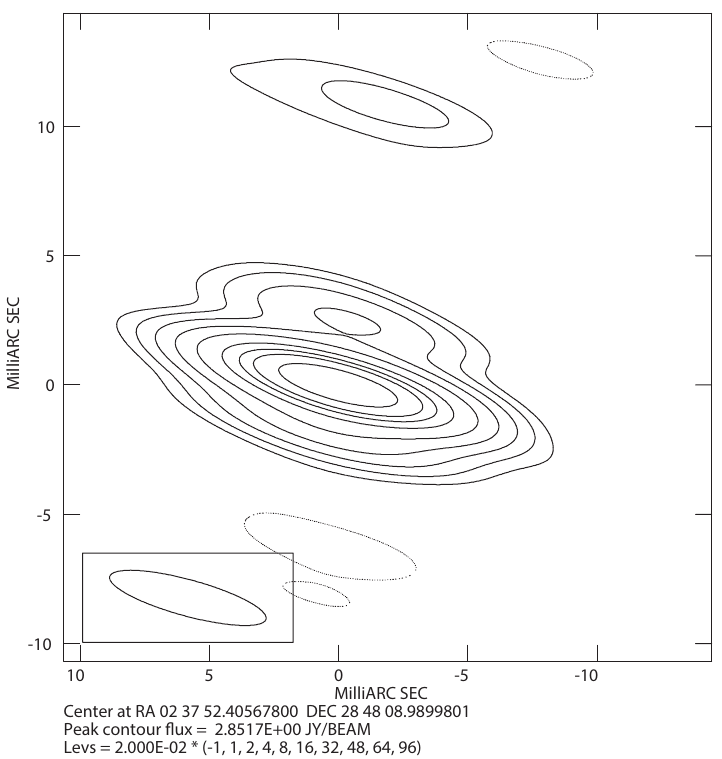
Fig. 5. The total intensity map of the source 0234+285 at 4.990 GHz, the experiment EG069C. The lines in black represent the intensity of the levels with the peak flux 2.8 Jy/beam. The ellipse in the left bottom corner is the synthesized beam of the EVN